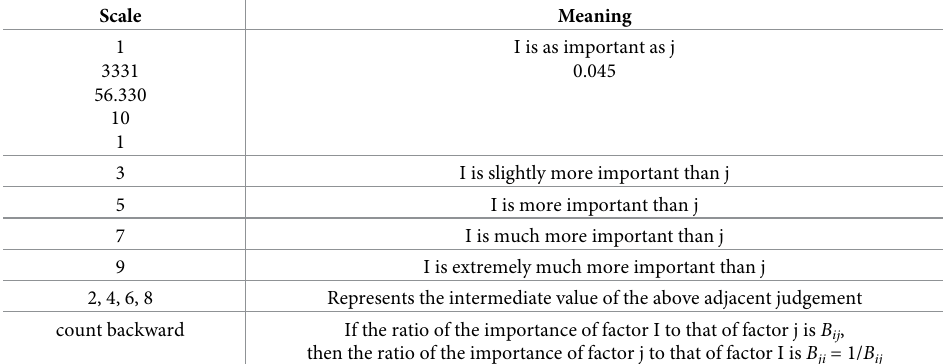
Table 3. Scaling criteria for cloud